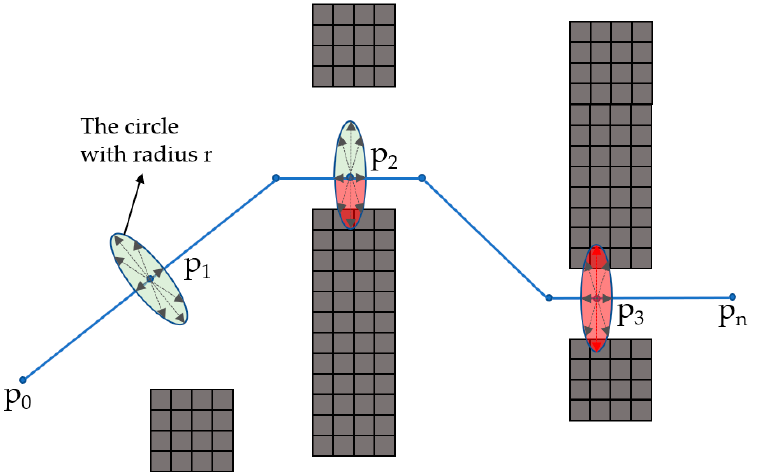
Figure 3. Using the guiding path (blue path) to perceive the narrow space. The green circle represents the point in spacious space, and the red circle represents the point in narrow space.